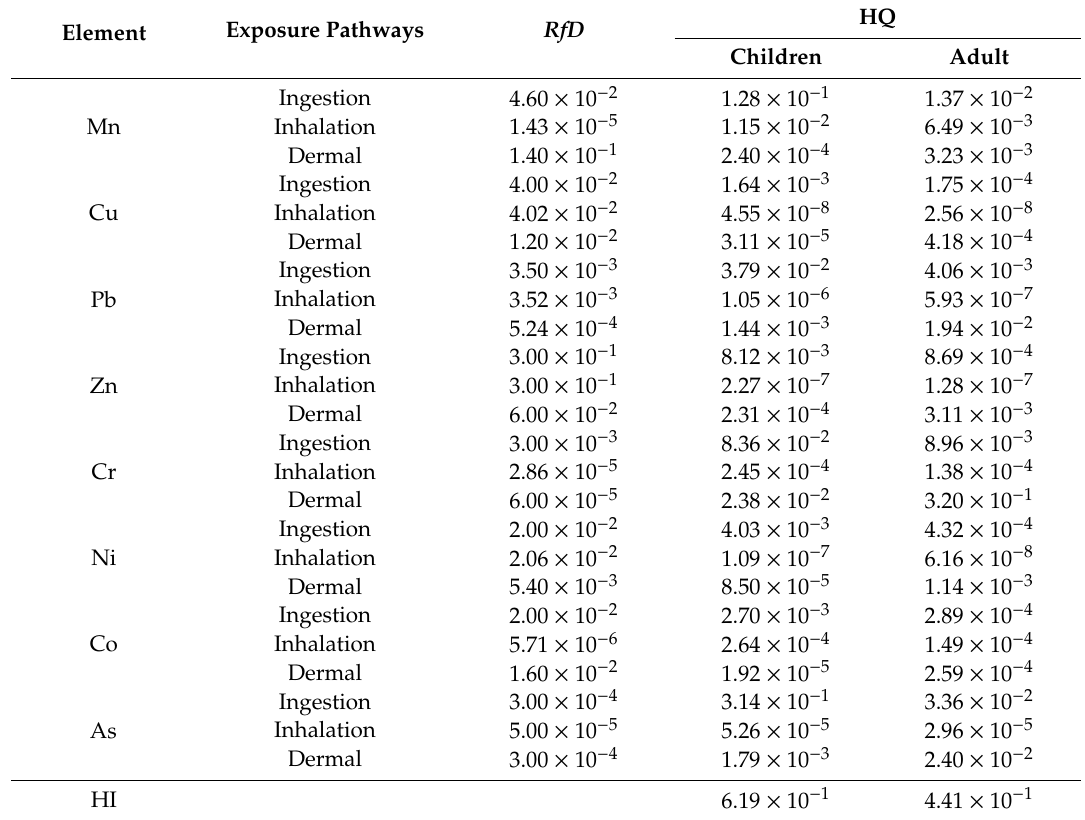
Table 3. Non-carcinogenic health risk from metals in the volcanic soil and volcanic ash. Element